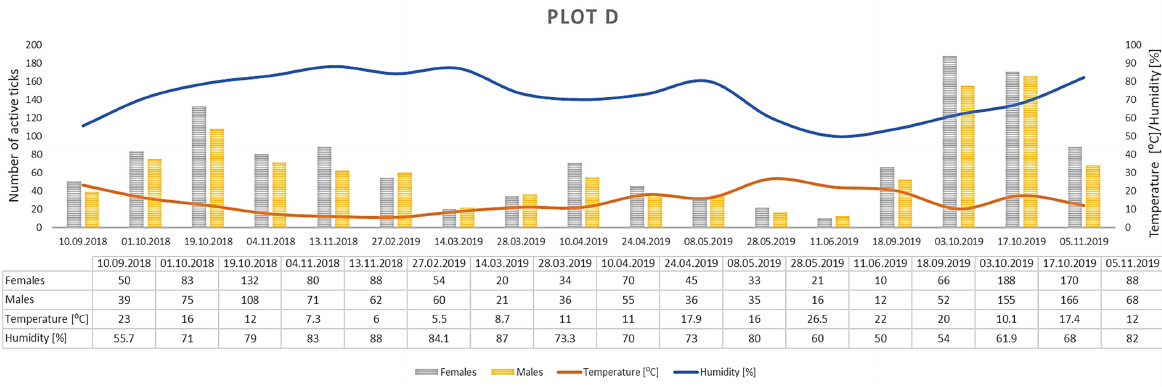
Figure 6. Abundance and seasonal activity of Dermacentor reticulatus adults in research plot D and weather conditions prevailing during tick collection. Predominance of active ticks in autumn.